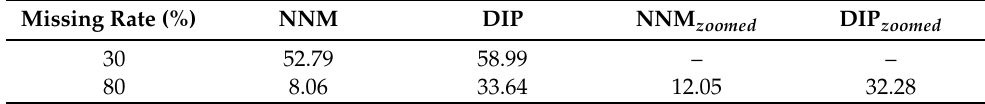
Table 5. PNSR comparison of data recovery methods for column-wise missing case for real data-I. Missing Rate